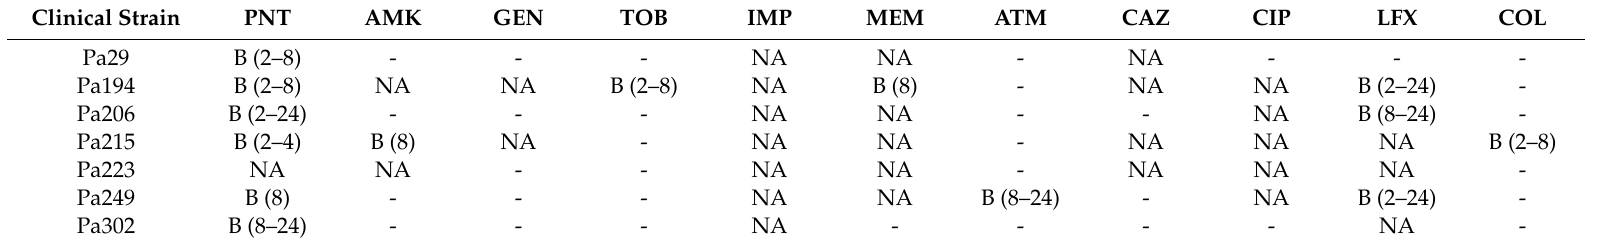
Table 2. Bactericidal activity of antimicrobials alone against the seven Pseudomonas aeruginosa clinical